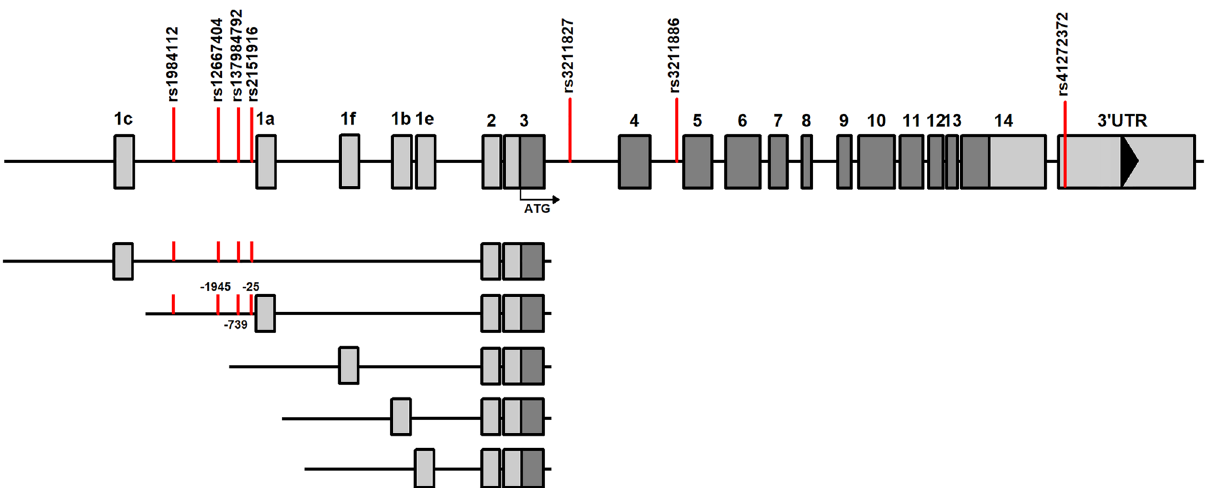
Figure 4. Position of 7 polymorphisms in the gene for CD36 and exons and different 5 ′ untranslated region of CD36 gene. Light shadow boxes represent untranslated mRNA sequence, the dark shadow box represents the translated sequence. The positions of identified CD36 polymorphisms are marked by red vertical lines. Overview of the 5 ′ untranslated region of CD36. Exon 1a denotes the alternative first exon and the accession number [GenBank: NM_001371077]. Exon 1b denotes the alternative first exon and the accession number [GenBank: NM_000072]. Exon 1c denotes the alternative first exon and the accession number [GenBank: NM_001371075]. Exon 1e denotes the alternative first exon annotated on the sequence and the accession number [GenBank: NM_001289909].